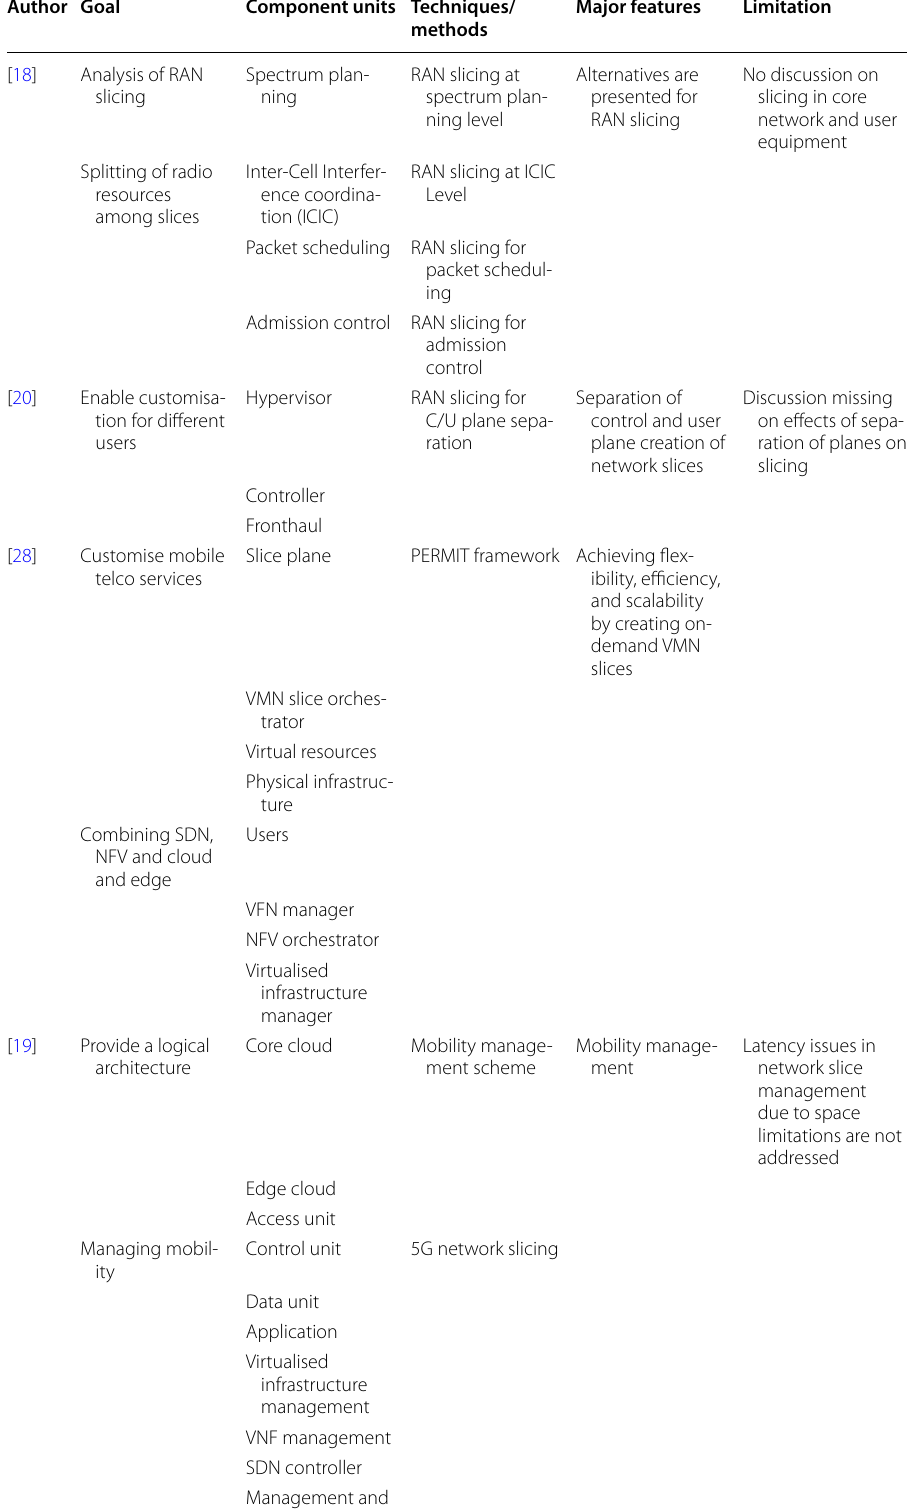
Table 5 Validation of publications using different factors Author